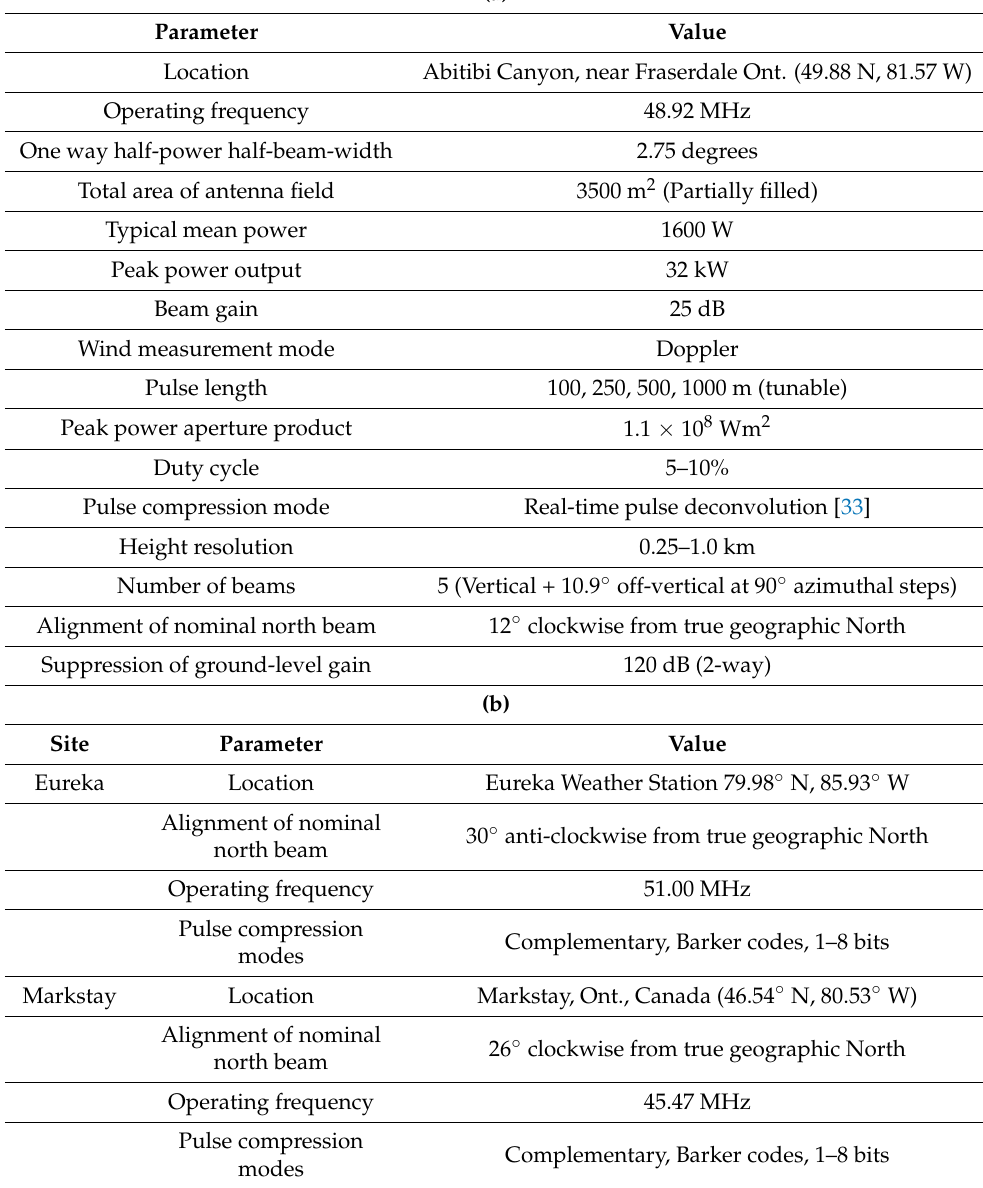
Table 1. (a) Parameters of the Abitibi radar. This table is also representative of Markstay and Eureka, although site-to-site variations do exist. Part (b) shows variations for the Markstay and Eureka